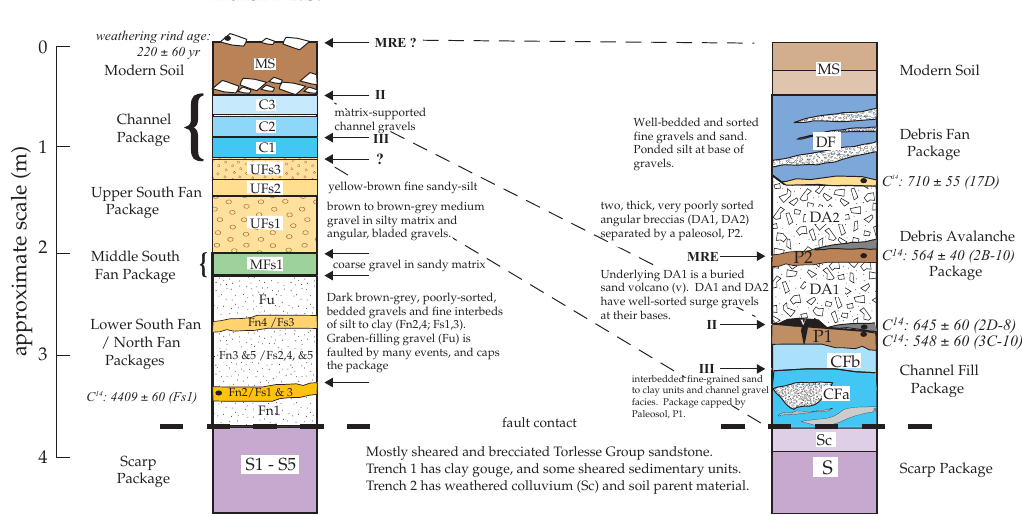
Fig. 6. Generalised stratigraphy and age of deposits from the Greenburn trenches. The youngest cover deposits at Trench 1 (Channel Package and modern soil) increase in thickness across the trench to the west and may be laterally contiguous with a thicker, expanded section in Trench 2 (dashed lines). Radiocarbon and surface ages are attached to the column. Horizontal arrows point to earthquake event